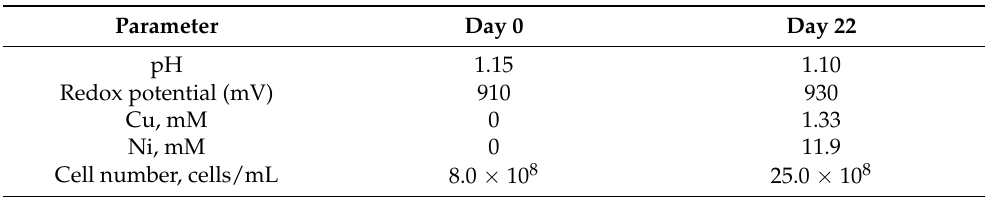
Figure 1. Iron concentration in the liquid phase of the pulp during bioleaching of the concentrate. Table 2. Parameters of the pulp liquid phase (pulp density, 1 wt%) at the beginning and after 22 days of bioleaching of copper–nickel concentrate in a bioreactor at 40 ◦